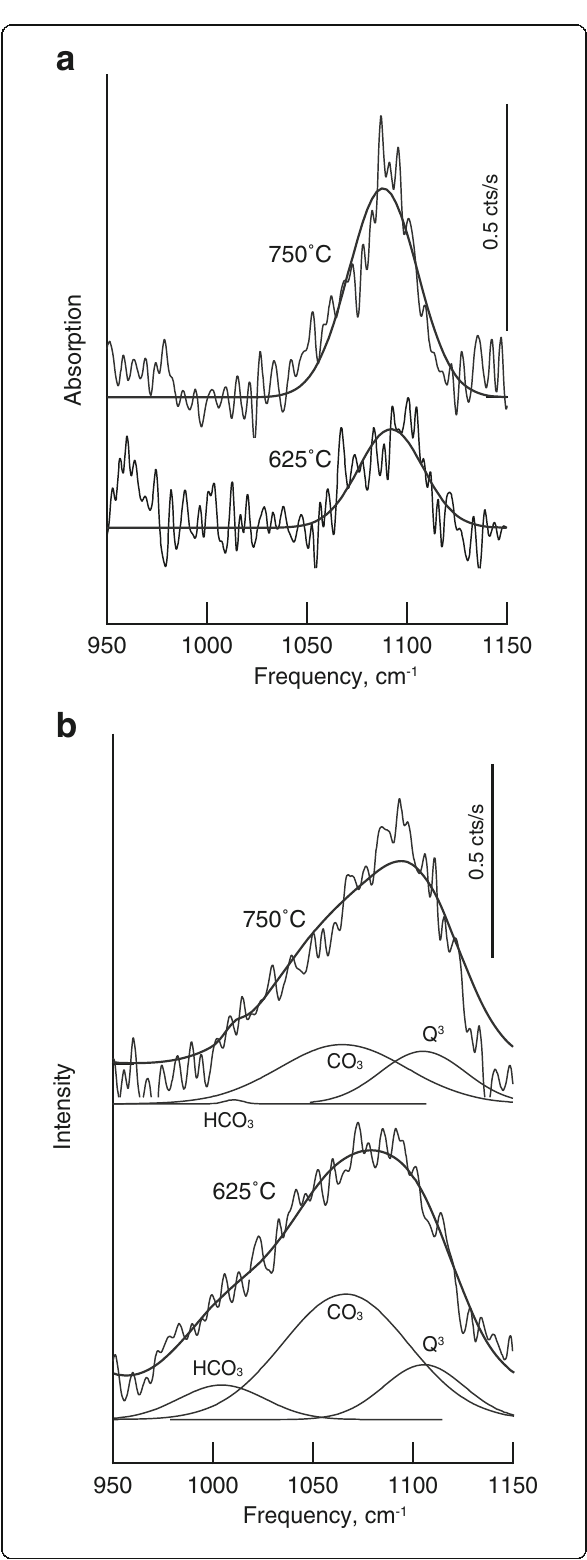
Fig. 8 Example of Raman spectra of silicate – C – O – H – N fluid and melt at 625° and 750 °C, respectively, fitted to Gaussian lines in the 950 – 1150 cm − 1 frequency range. a Spectra from fluid with a single line assigned to C – O vibrations in CO 3 groups. b Spectra from melts where three lines are needed. These are assigned to C – O stretching in HCO 3- and CO 32- groups and to Si – O stretching in Q 3 silicate species (see text for discussion on these assignments)